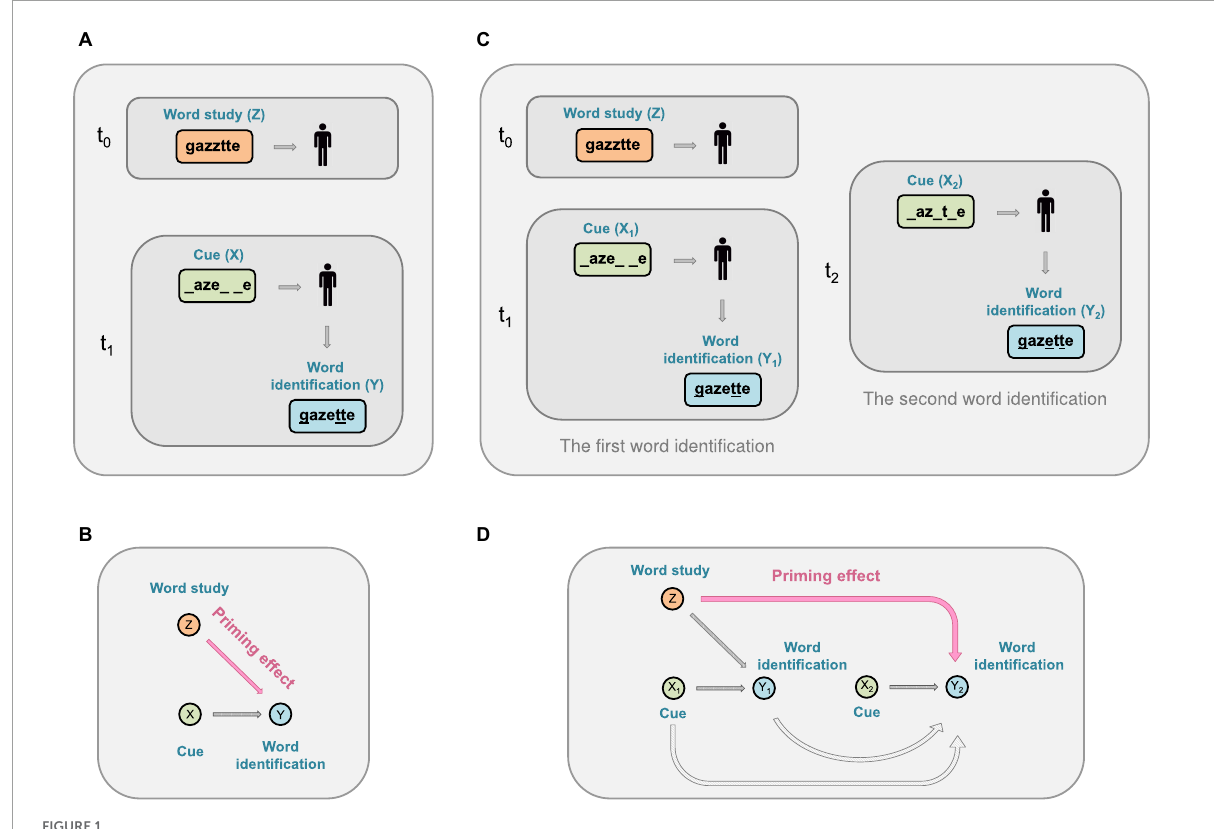
FIGURE1 A schematic representation of the priming effect during a word completion experiment. (A) First, a subject views a list of words (including a target word gazette, or Z) during a word study. Next, a cue that consists of a fragment of the word (e.g., _aze_ _e, or X) is given to the subject. The subject is then asked to fill in the blanks. The subject may successfully uncover the target word or another word gazelle; or report a non-word gazeele, or an incomplete entry such as _azelle. (B) Priming effect refers to the phenomenon that being previously exposed to the word gazette (Z) primes (i.e., facilitates) the identification of the word (Y) given a partial or reduced cue (X). (C) A word study followed by two-word identifications. Left: The same word study and the subsequent cue-based identification, as in (A) . Right: An additional cue-based identification. In the figure, a different cue (e.g., _az_t_e, or X 2 ) is used during the second word identification for illustration purposes; two identical cues can also be used. (D) Priming effect where being previously exposed to the word gazette (Z) primes (i.e., facilitates)